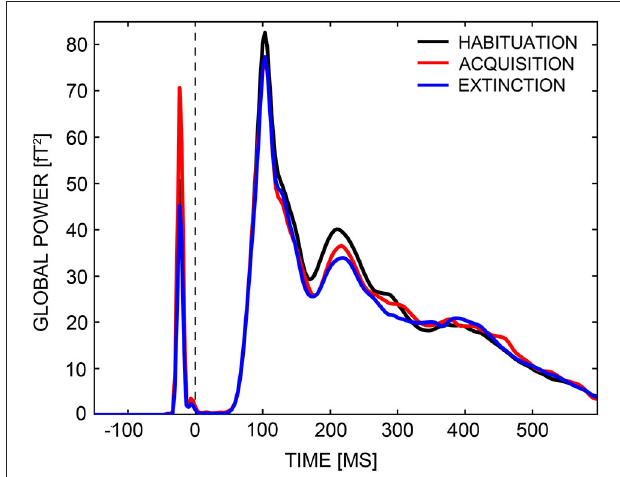
FIGURE 3 | Global power plot . Global power of field strengths across all sensors are displayed for the habituation (black line), acquisition (red line), and extinction (blue line) phases across a time-interval, ranging from − 150 ms to 600 ms. A delta peak like technical trigger artifact occurred at around − 20